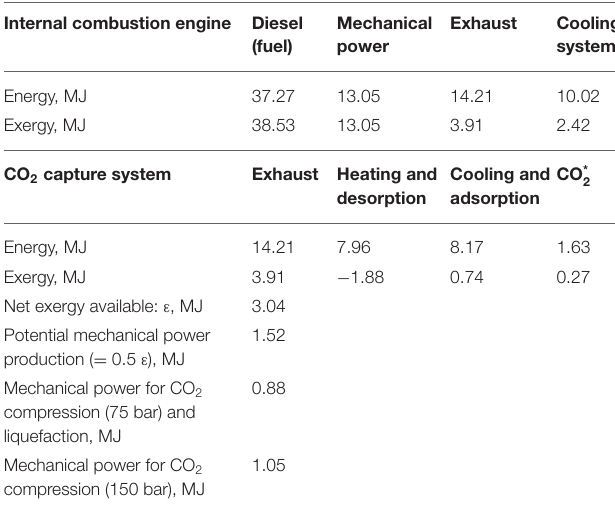
TABLE 1 | Energy and exergy analyses of the internal combustion engine, the CO 2 capture system, and compression power required for CO 2 liquefaction (1l diesel). Internal combustion engine Diesel (fuel)